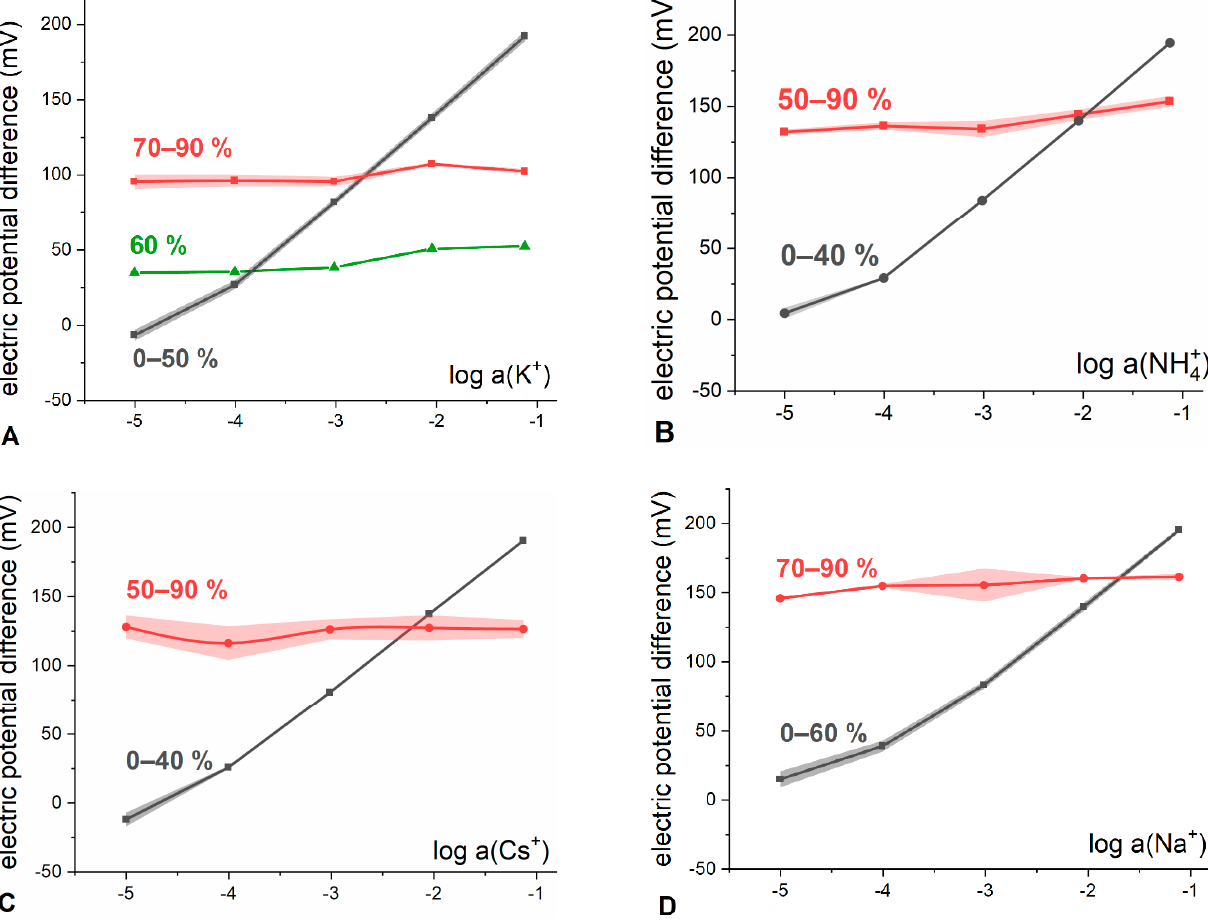
Figure 4. The response of the electrodes containing both KT p ClPB and ETH500 in the membrane, to potassium ( A ); ammonium ( B ); cesium ( C ), and sodium ( D ) ionic activity. ETH500 content was varied from 0 to 90 mol. % of the overall salt quantity (indicated in the plots). When possible, for better clarity, the values of E for the membranes with different ETH500 content were averaged and the resulting dispersion of the potential difference is represented as shaded areas.